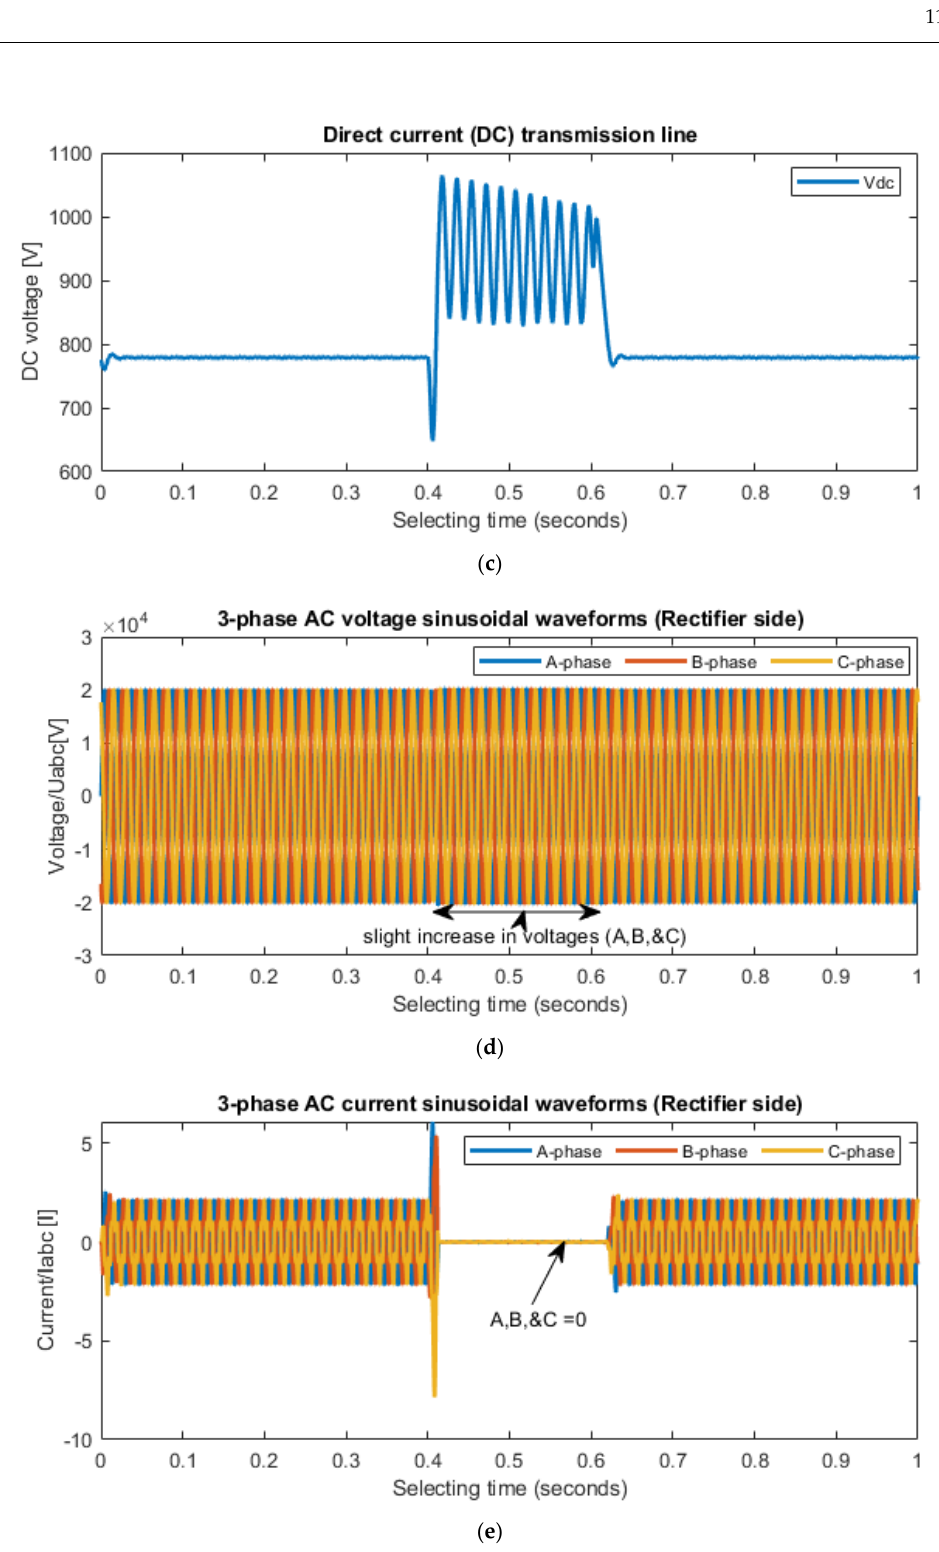
Figure 5. Simulation results for HVDC system during a three phase-to-ground (LLLG) fault at station 2. ( a ) Three-phase AC voltages at the inverter side. ( b ) Three-phase AC currents at the inverter side. ( c ) DC line voltage. ( d ) Three-phase AC voltages at the rectifier side. ( e ) Three-phase AC currents at the rectifier